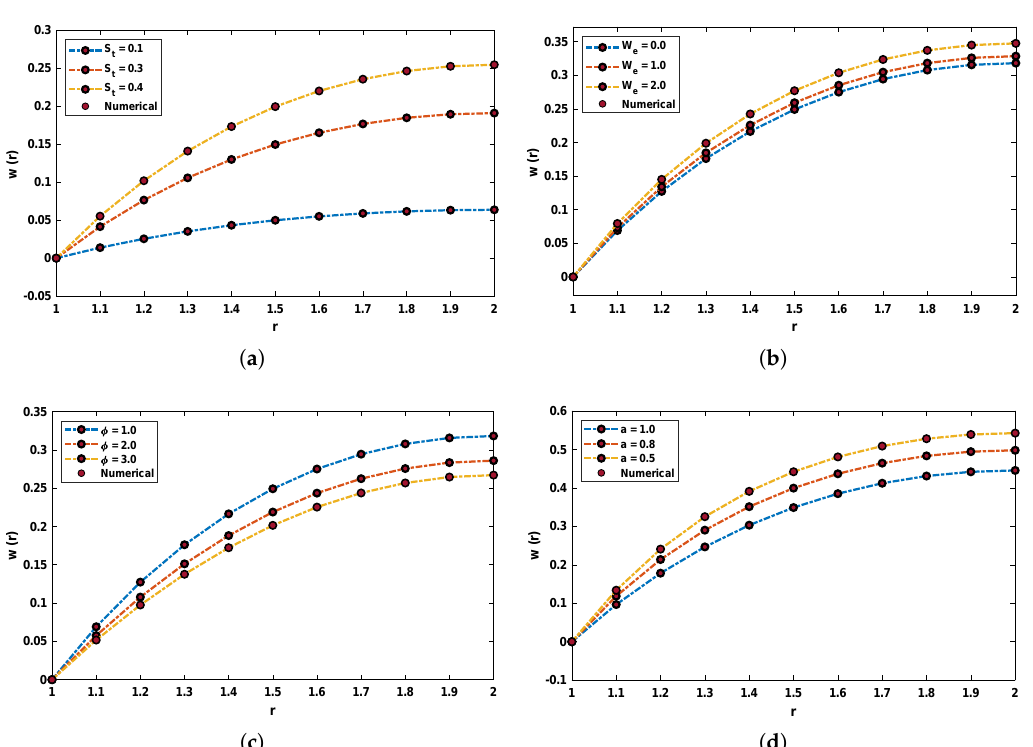
Figure 5. Comparison of dimensionless velocity profile obtained by LNN-GNDO-SQP algorithm with RK-4 method for variants of drainage problem. ( a ) SCENARIO I. ( b ) SCENARIO II. ( c ) SCENARIO III. ( d ) SCENARIO